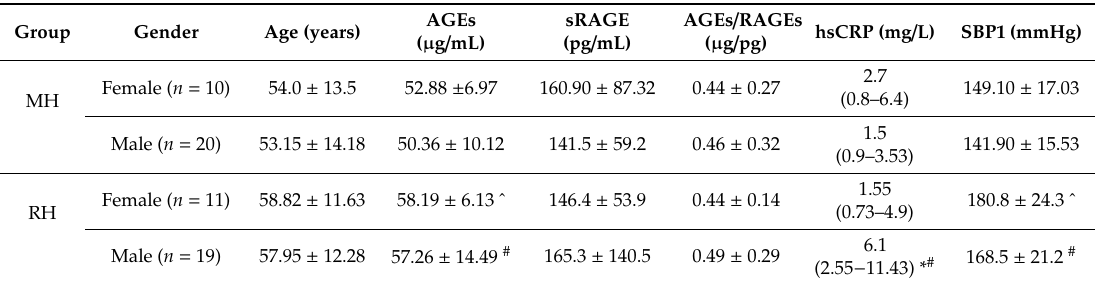
Table 4. The influence gender on AGEs, RAGEs, AGEs / RAGEs ratio, hsCRP and SBP1 in MH and RH patients.